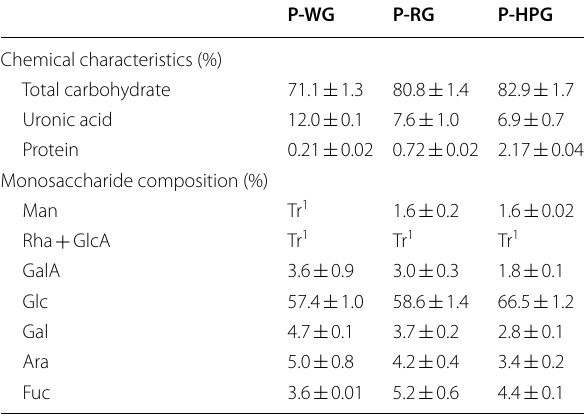
Table 3 Chemical and monosaccharides composition of P‑WG, P‑RG, and